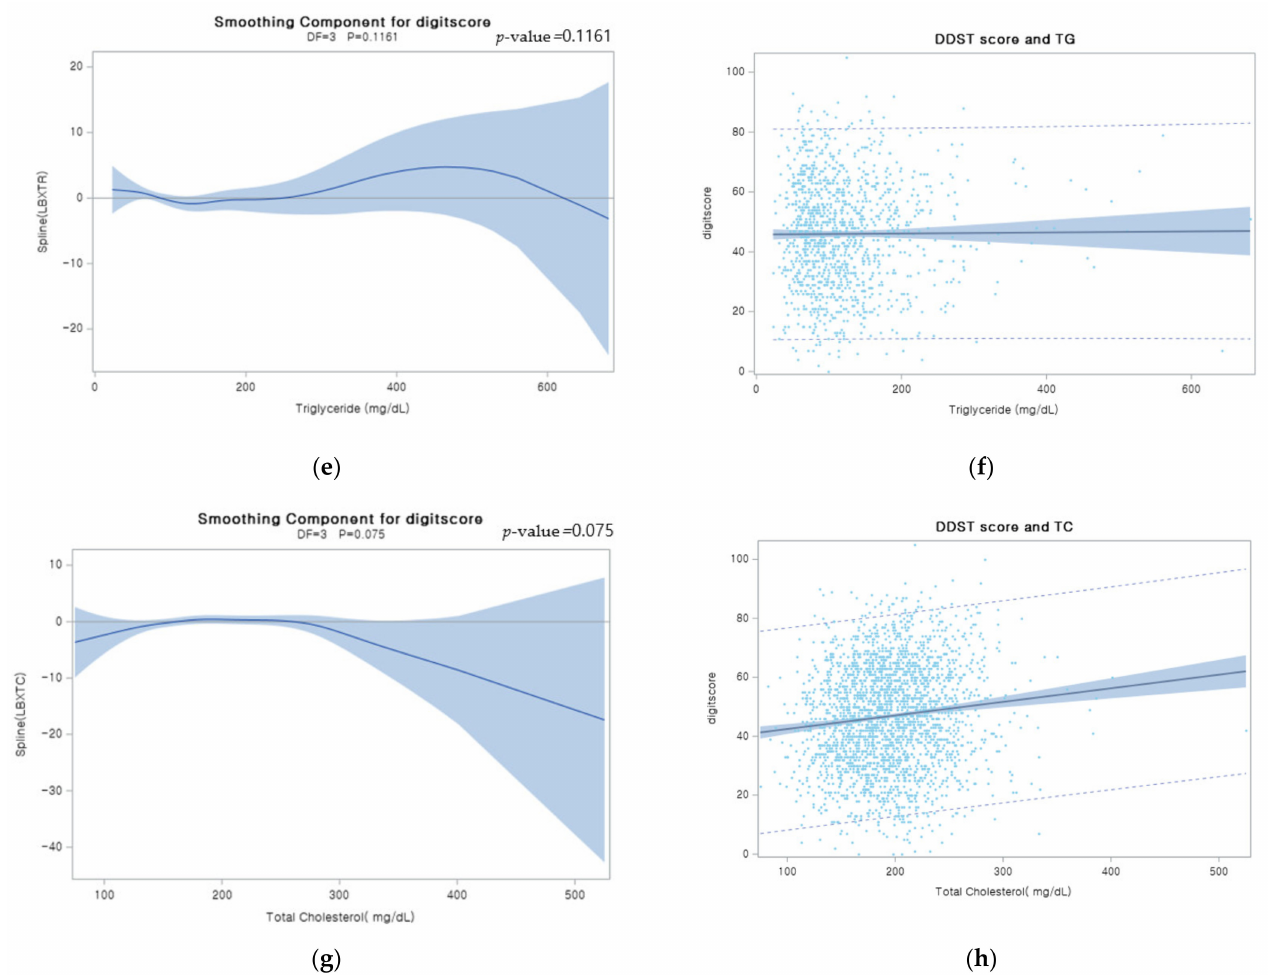
Figure 2. Plots of smoothing spline function of digit score ( a ) Plots of estimated smoothing spline function of digit score with 95% confidence band for Generalized Additive Model (GAM) when the independent variable was HDL. ( b ) Scatter plots of HDL when the independent variable was HDL. Smoothing spline estimated on the basis of the distribution of digit score and HDL. Light blue color band indicated 95% confidence interval range of the distribution. ( c ) Plots of estimated smoothing spline function of digit score with 95% confidence band for Generalized Additive Model (GAM) when the independent variable was LDL; ( d ) scatter plots of HDL when the independent variable was LDL. ( e ) Plots of estimated smoothing spline function of digit score with 95% confidence band for Generalized Additive Model (GAM) when the independent variable was TG. ( f ) Scatter plots of HDL when the independent variable was TG. ( g ) Plots of estimated smoothing spline function of digit score with 95% confidence band for Generalized Additive Model (GAM) when the independent variable was TC. ( h ) Scatter plots of HDL when the independent variable was